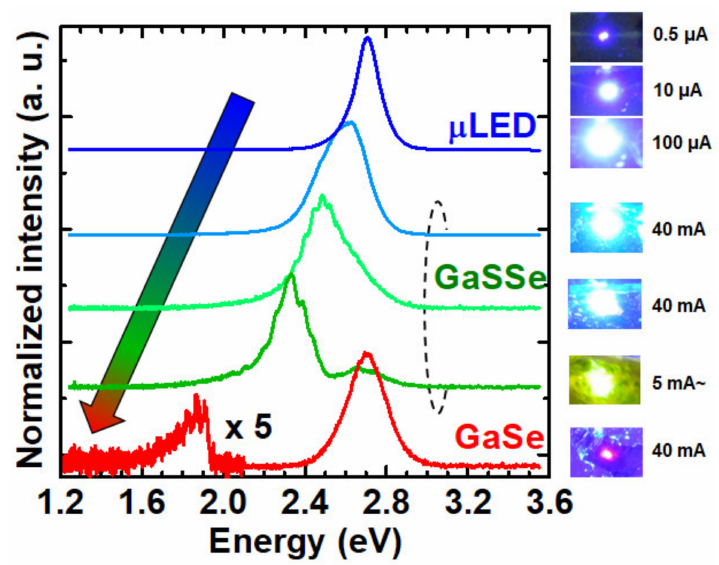
Figure 3. Electroluminescence (EL) Spectra of GaN-based µ LED chips with and without GaS 0.65 Se 0.35 and GaSe thin films as green and red converters. The inset photographs show EL images of µ LED chips with GaS 0.65 Se 0.35 and GaSe films. The thicknesses were 44, 60 and 98 µ m for GaSSe, and 72 µ m for GaSe.